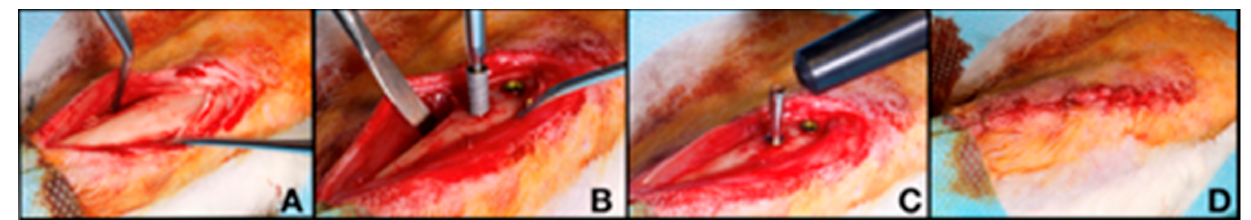
Figure 1. Surgical procedure. Incision and full-thickness flap ( A ). Placement of two 3.0 × 8 mm Klockner Vega implants in each tibia ( B ). Measurement of primary stability (ISQ) using a Penguin RFA device ( C ). Suture of the wound by tissue planes and primary closure over the healing caps ( D ).